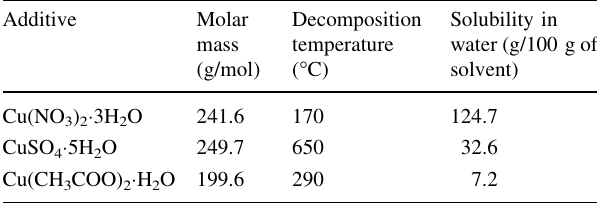
Table 1 Characteristics of the starting chemicals (Wayne 2005) Additive Molar mass